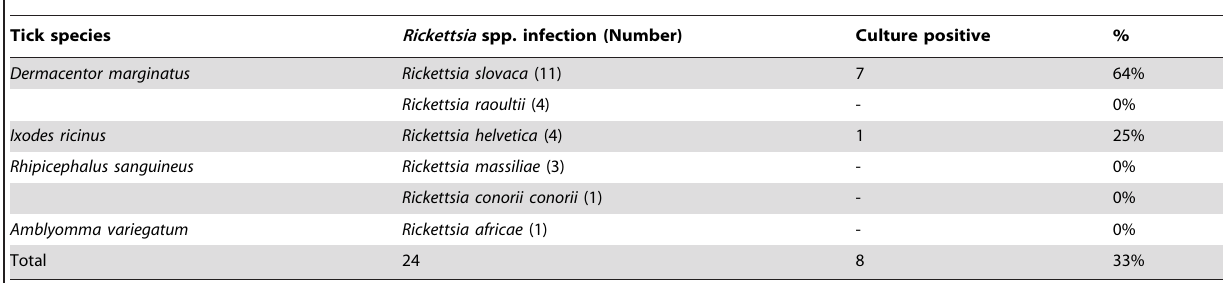
Table 2. Results of PCR assays and culture of the 95 ticks.